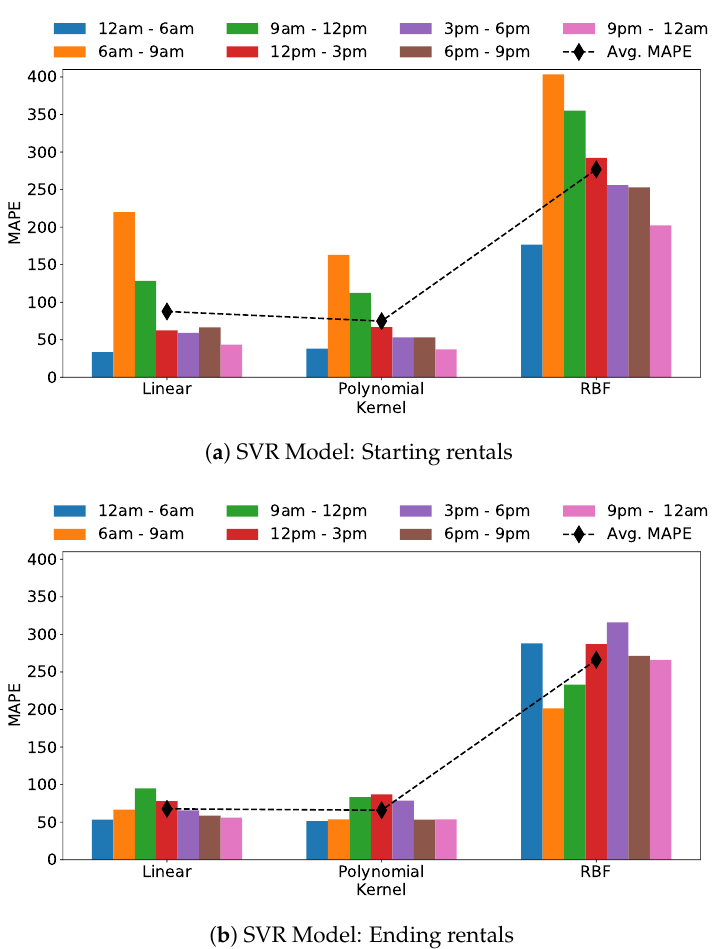
Figure 10. Spatial prediction—MAPE for Support Vector Regression models, using different